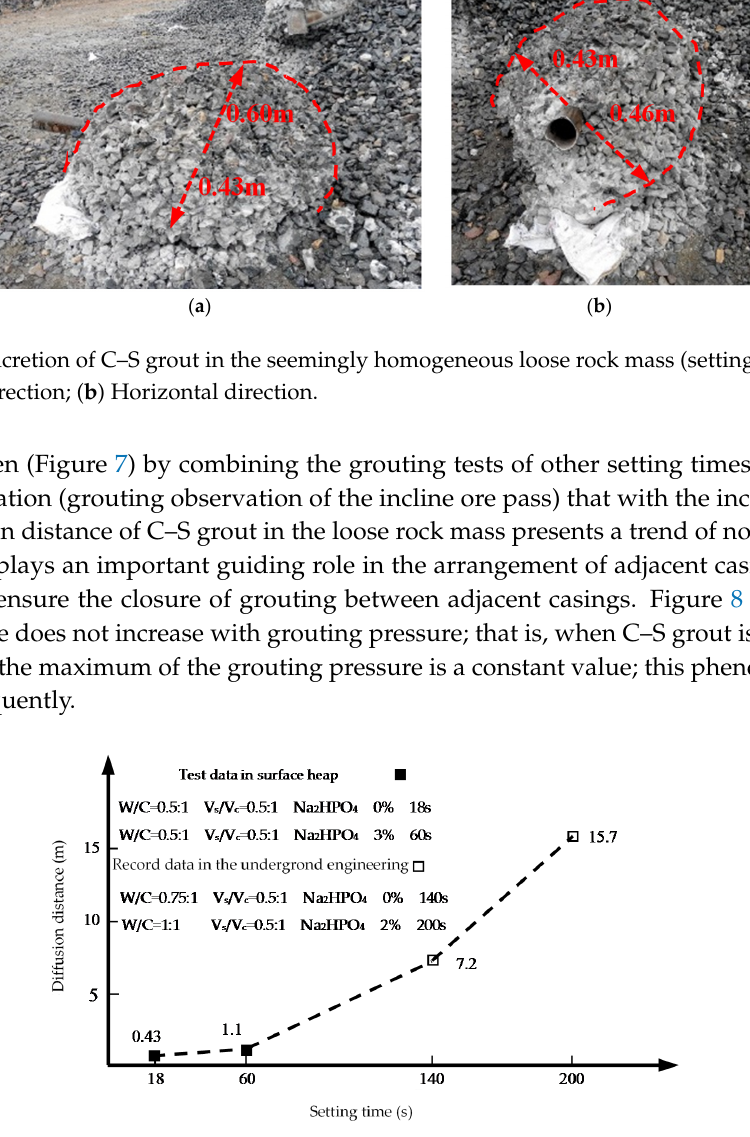
Figure 7. Relationship of setting time–vertical diffusion distance of C–S grout in the loose rock mass. W/C: water cement ratio; Vs/Vc: volume ratio of sodium silicate to cement slurry.